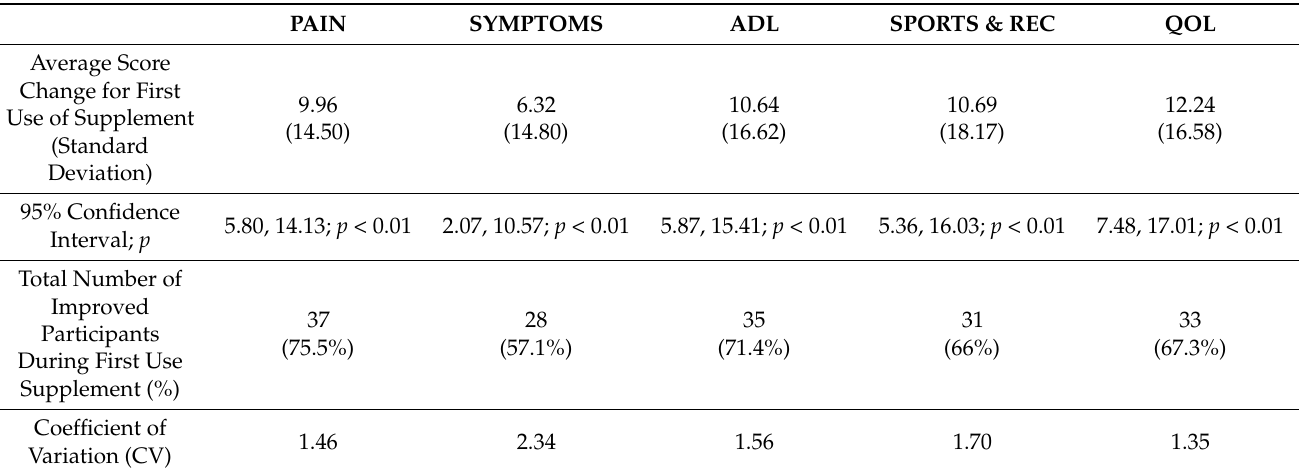
Table 1. KOOS Scores Changes for First Use of Supplement Cohort. The Supplement Group’s T0–T1 and the Placebo Group’s T2–T3 phase intervals scores were combined to form the First Use of Supplement Cohort ( n = 51). For each of the five categories, the changes were statistically significant ( p <